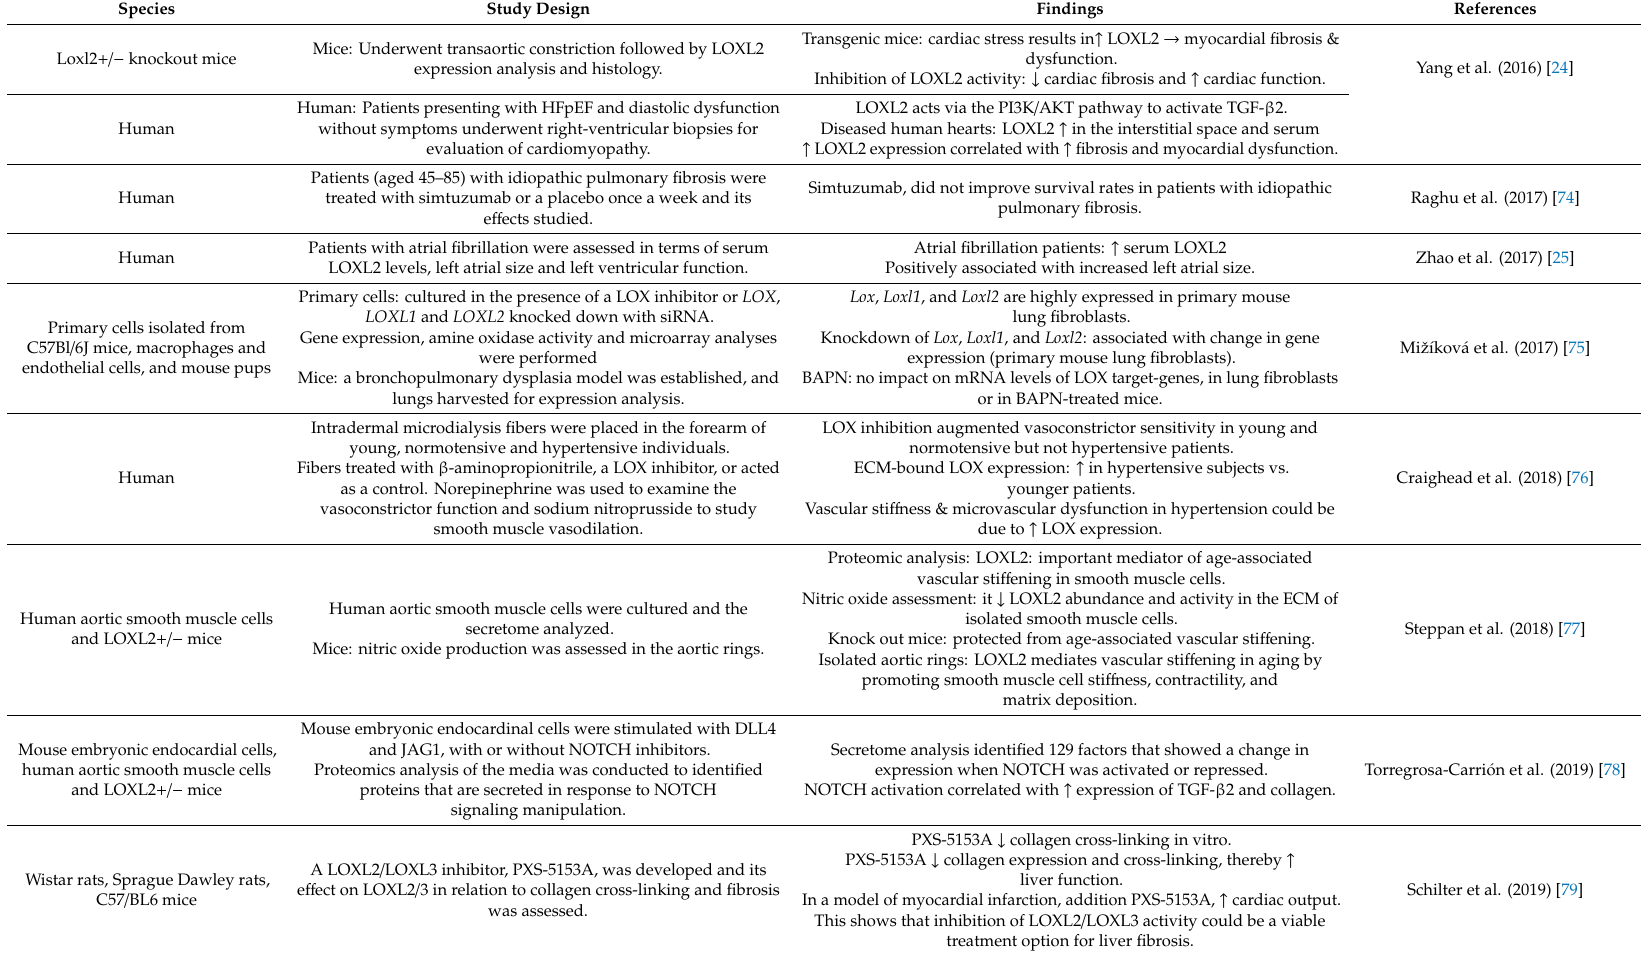
Table 1. Summary of articles investigating LOXL2 and fibrosis in cardiovascular